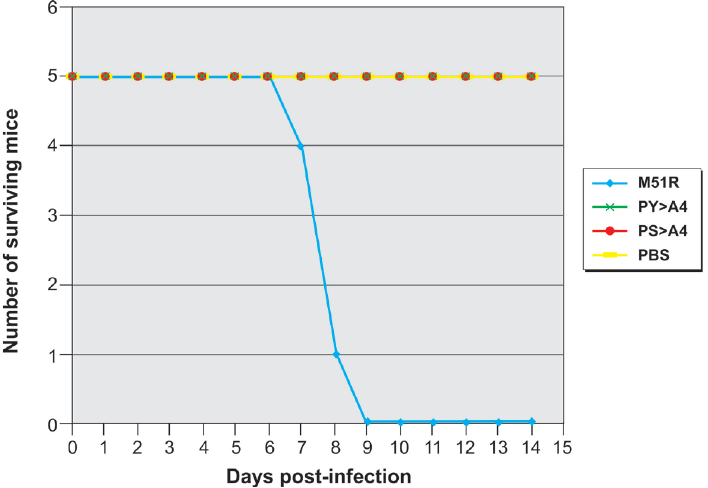
Figure 3. Survival of virus infected mice. Groups of eight mice were mock infected (PBS, yellow), or infected intranasally with 10 7 p.f.u. of M51R (blue), PY > A4 (green), or PS > A4 (red), and survival was monitored on a daily basis for a two-week period. All data points for PBS, PY > A4, and PS > A4 fall on the same horizontal